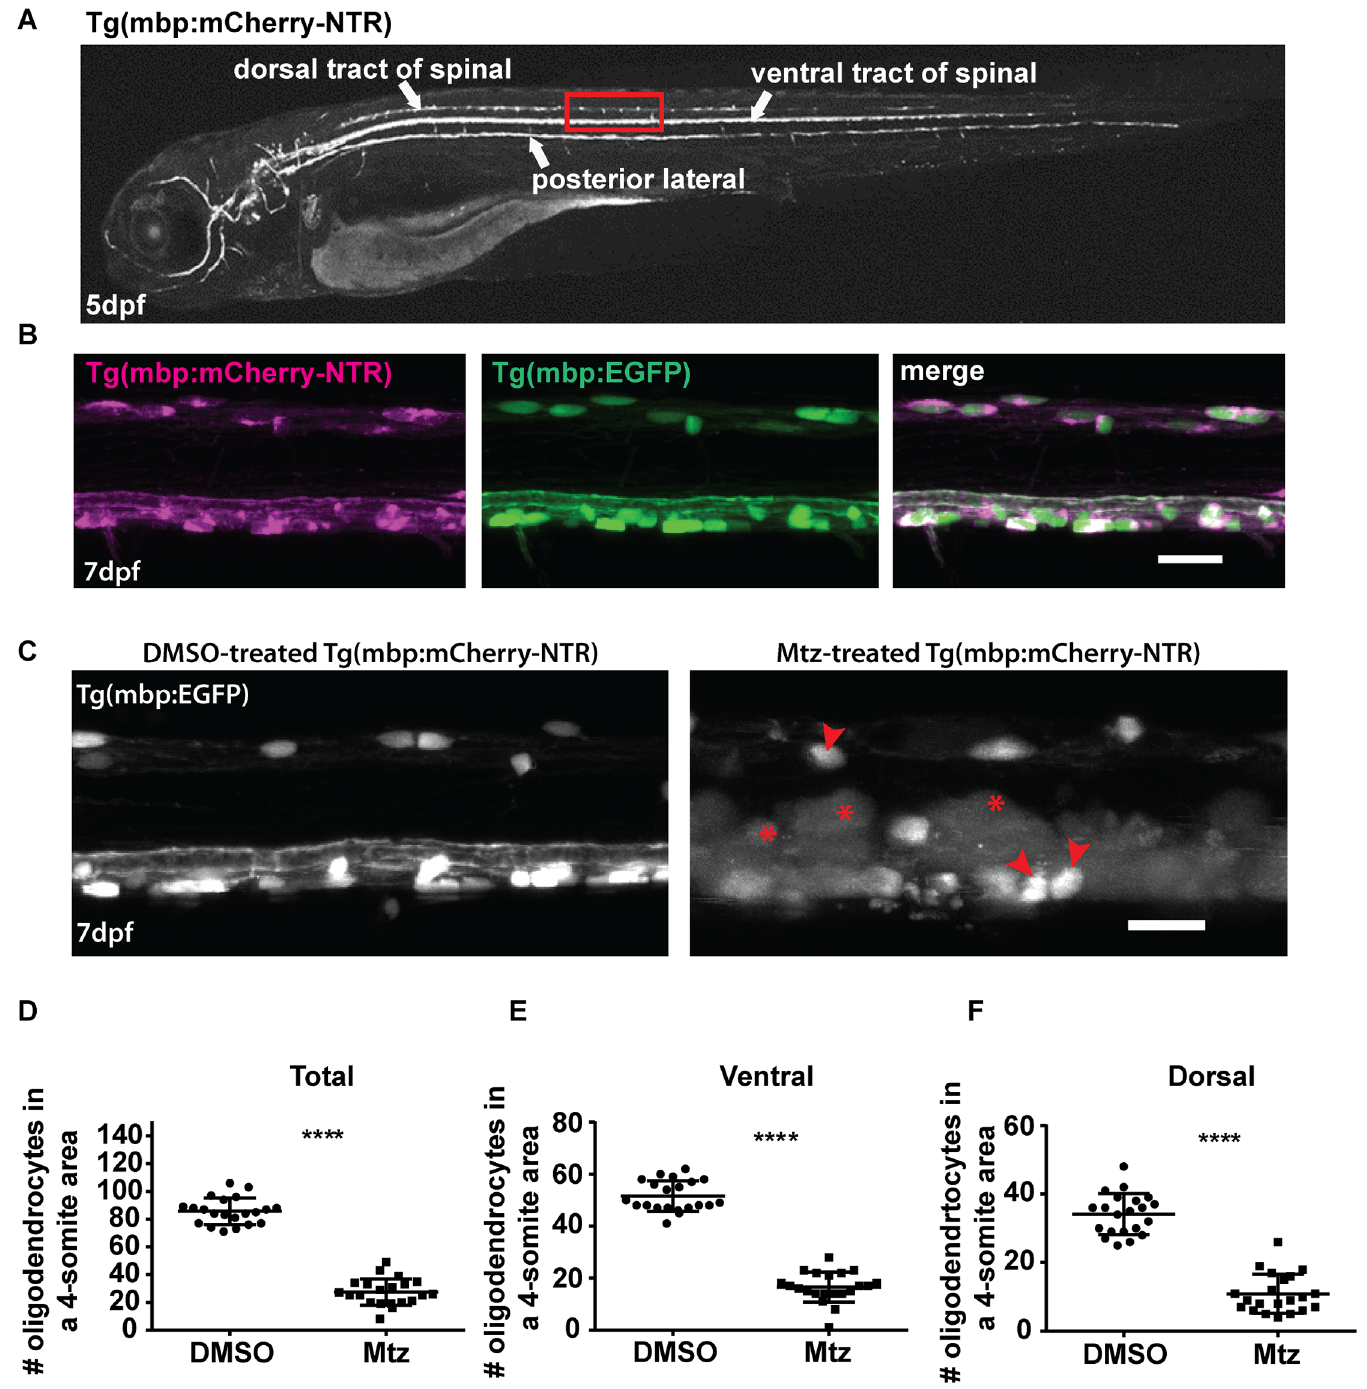
Fig 1. Oligodendrocyte ablation using the Tg(mbp:mCherry-NTR) model. A . Top panel:brightfieldimage of a Tg(mbp:mCherry-NTR) larva at 5dpf. Bottom panel: fluorescent mage showingthe expressionof the mbp:mCherry-NTR transgenein the larva. The dorsal and ventral tracts of the spinal cord and the posterior lateral line are indicated.The red box outlines the regionthat is shown in highermagnification in B (in anotheranimal). B . Lateral views of the spinalcord of doubletransgenic Tg(mbp:mCherry-NTR);Tg(mbp:EGFP) larvae at 7dpf, showingcompleteoverlap of the mCherry and GFP channels.Scale bar: 20 μ m. C .Oligodendrocyte ablationin Tg(mbp:mCherry-NTR) animalsfollowingtwo-day treatment with Mtz. Red arrowheadsindicate unaffected oligodendrocytesand red asterisks indicatevacuolatedstructures. Scale bar: 20 μ m. D-F . Quantification of oligodendrocyte numbers from a four-somite stretch of the spinal cord in the entire region( D ) ventral ( E ) and dorsal( F ) tracts of DMSO and Mtz-treated larvaeat 7dpf (immediately followingtreatment). Overall oligodendrocyte number(dorsal and ventral combined), controls: 85.71 ± 2.1 vs treated: 27.48 ± 2.1 (68% reduction, p < 0.0001).n = 21. In the